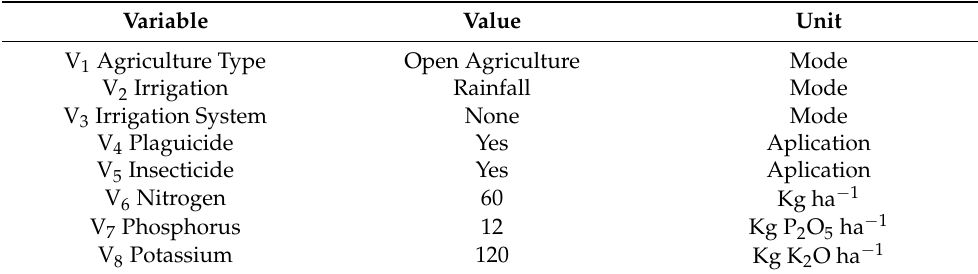
Table A5. Fuzzy model input parameters: Crop yield.